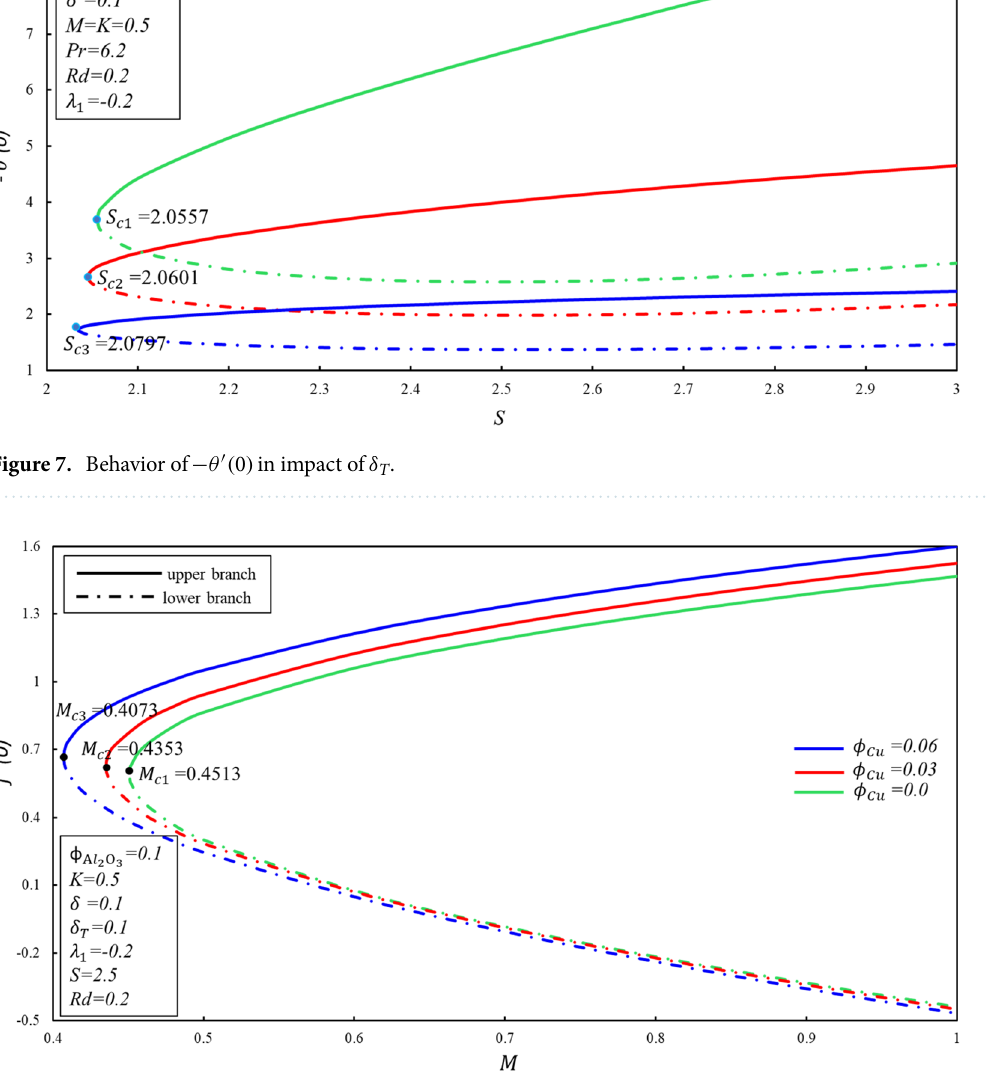
Figure 8. Behavior of f ′′ ( 0 ) in impact of φ Cu